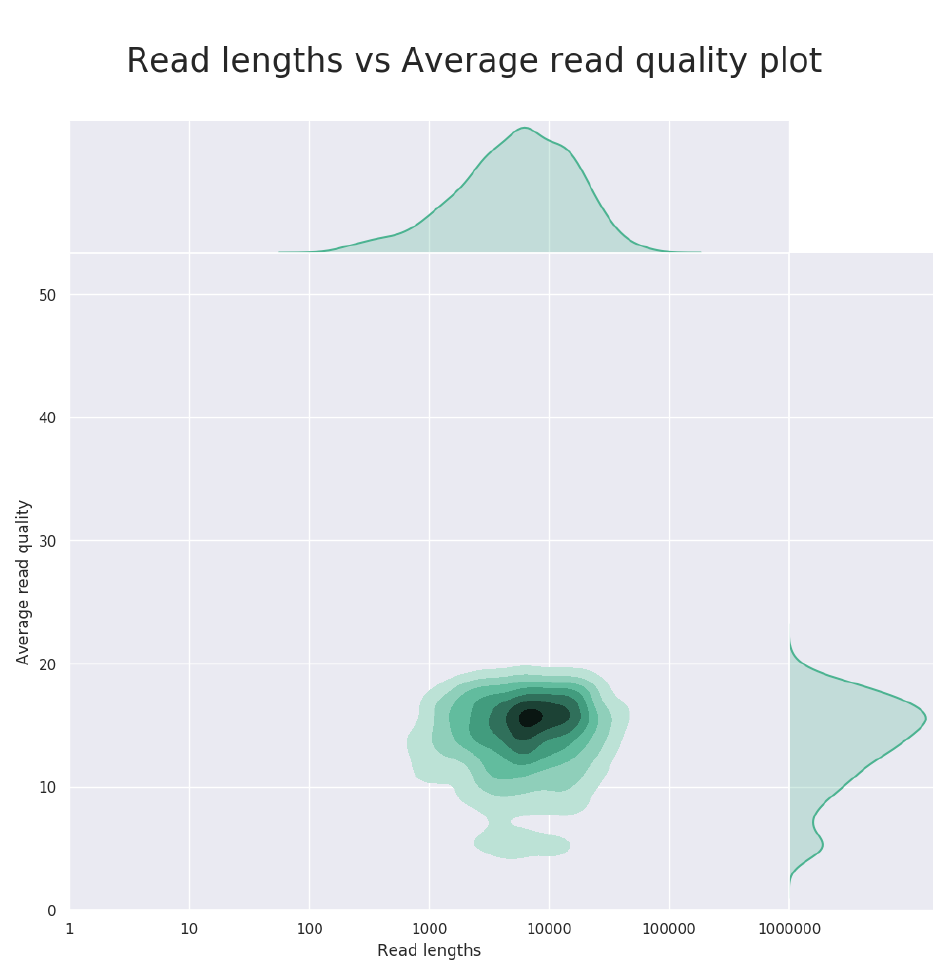
Figure A4. Histogram of read length and quality of unsubsampled